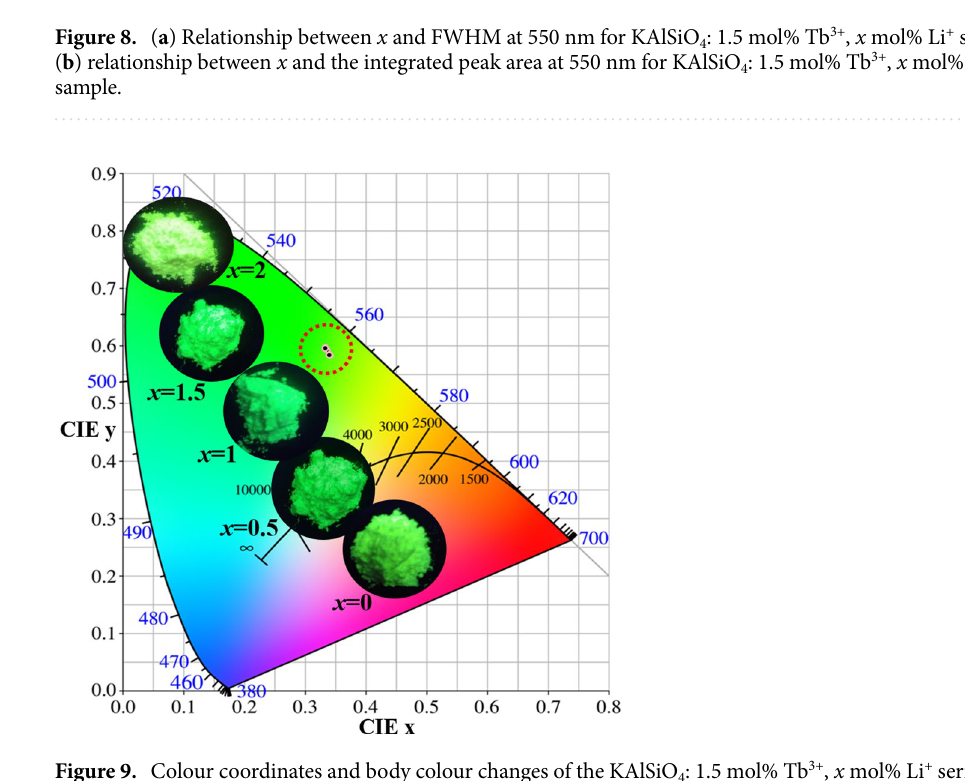
Figure 9. Colour coordinates and body colour changes of the KAlSiO 4 : 1.5 mol% Tb 3+ , x mol% Li + series